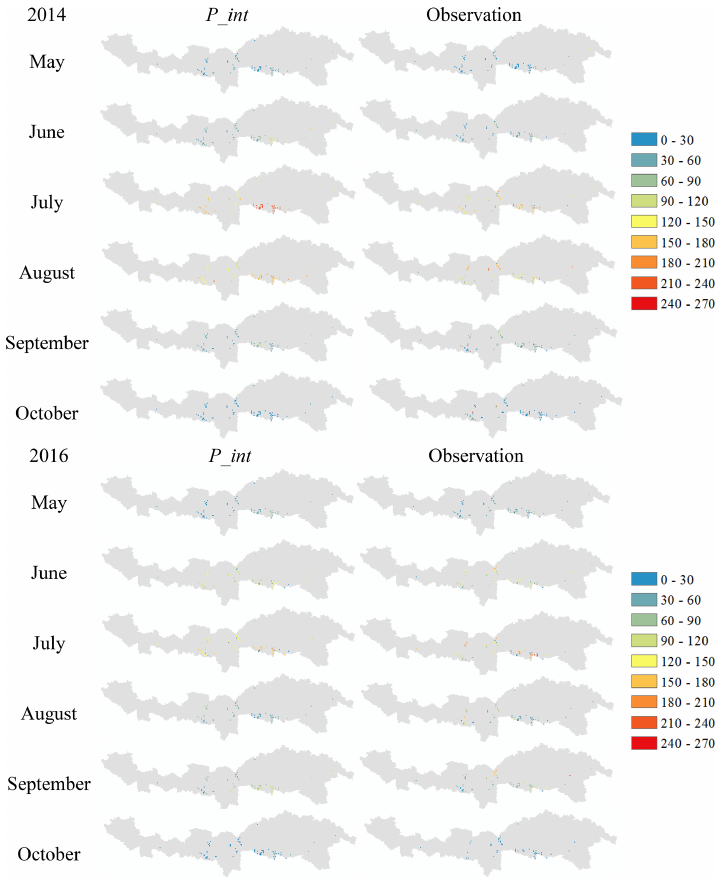
Figure 9. A validation of P _int (mm) against short time series: spatial distribution of the observations and corresponding grids in P _int from May to October in 2014 and 2016.